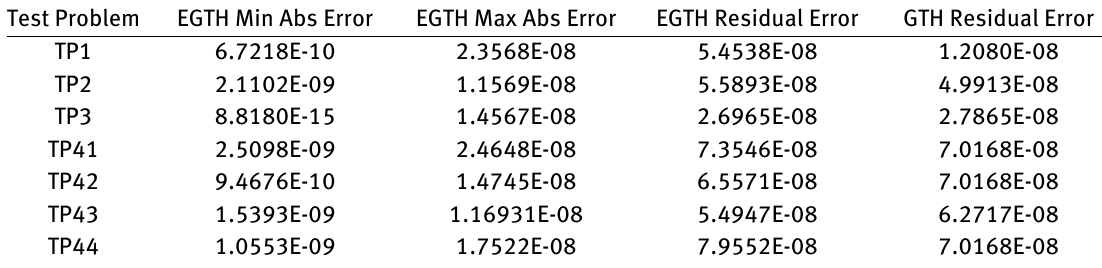
Table 5: Errors for the Stationary distributions under single